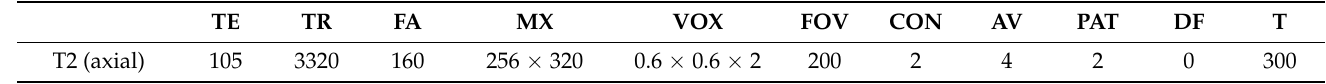
Table 1. Applied MR protocol in line with PIRADS